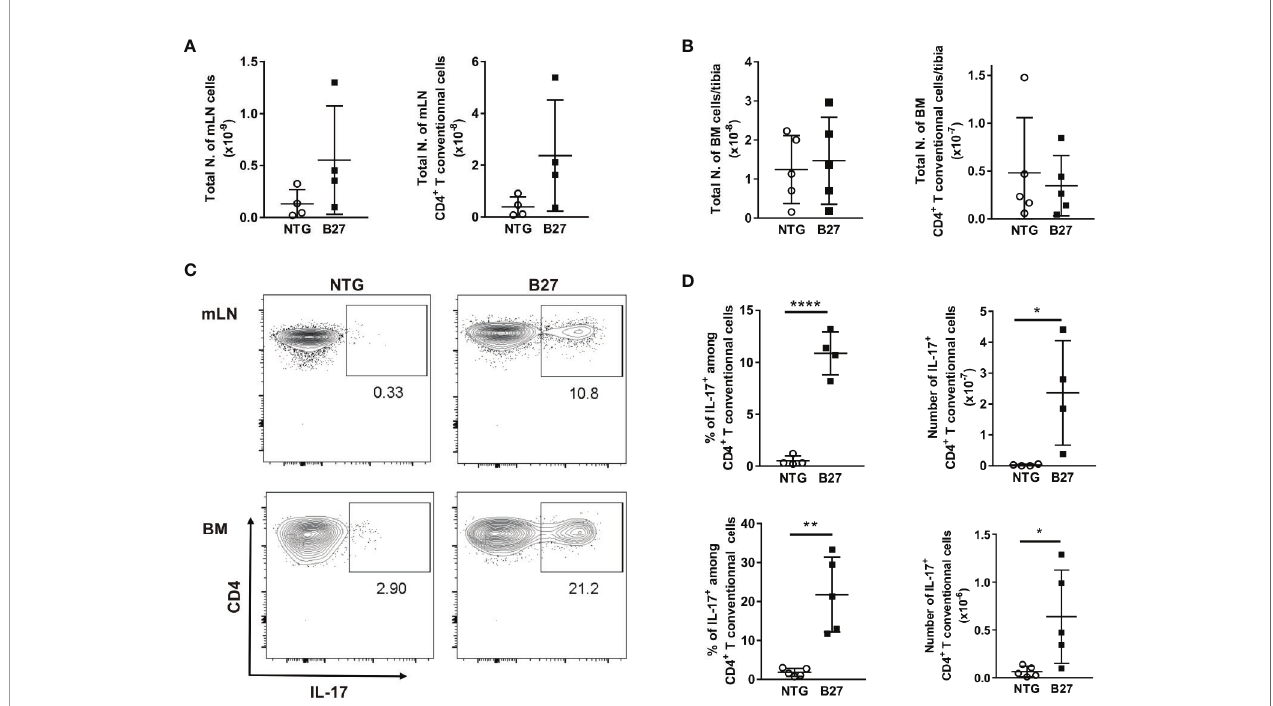
FIGURE 5 | Expansion of IL17+ producing CD4+ T cells in the bone marrow from B27 transgenic rats. (A) Absolute number of live cells and CD4 + T cells in mesenteric lymph nodes (mLN) from NTG (grey) and B27 (white) rats were determined using fl ow cytometry. (B) Absolute number of live cells and CD4 + T cells in bone marrow (BM) from NTG and B27 rats. (C) Representative plots of intracellular IL-17 staining gated on CD4 + Foxp3 - T cells in mLN (top) and BM (bottom) from NTG (left panel) or B27 (right panel) rats. (D) Frequencies of IL-17 + cells among CD4 + T cells (left) and their absolute numbers (right) in mLN (top) and BM (bottom) from NTG and B27 rats (A-D n=4-5 per group). Results are presented as individual dots with the mean indicated as horizontal line. Data were analyzed by unpaired Student ’ s t-test (*p<0.05, **p < 0.01 and ****p <